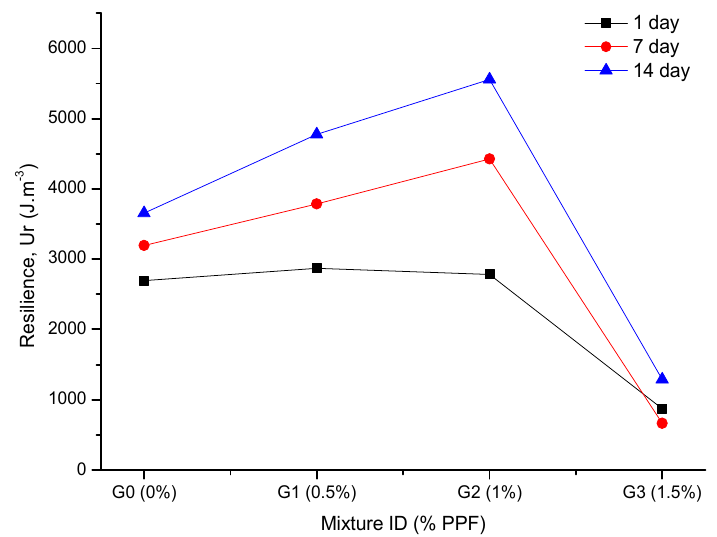
Figure 5. Effect of PPF content on resilience .